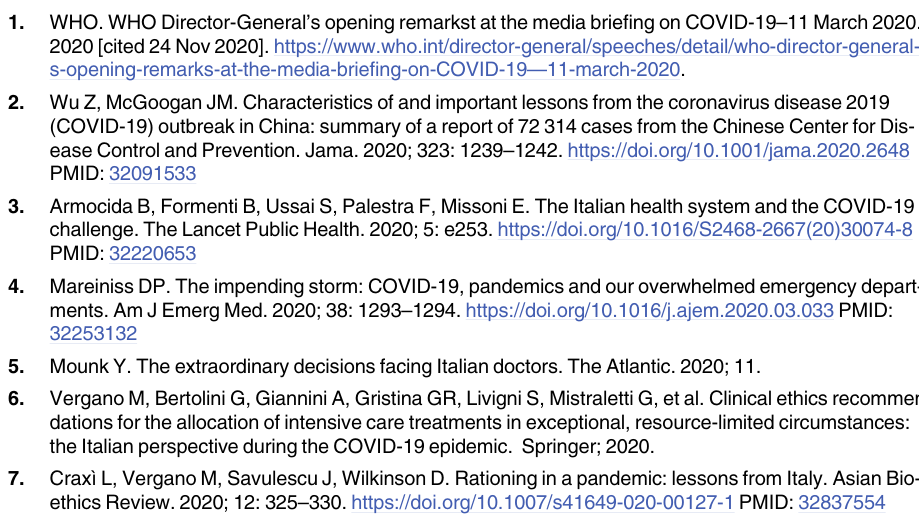
S1 Fig. Number of decision-maker categories preferred. S1 Table. Decision-makers; spearman correlation matrix agreement scores. S2 Table. COVID-19 related questions. S3 Table. Preferences for who should be involved in the allocation of ICU beds (N =